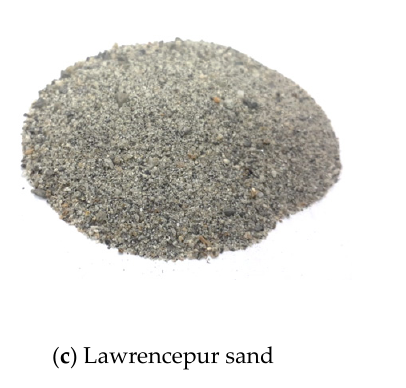
Figure 1. Physical appearance of the